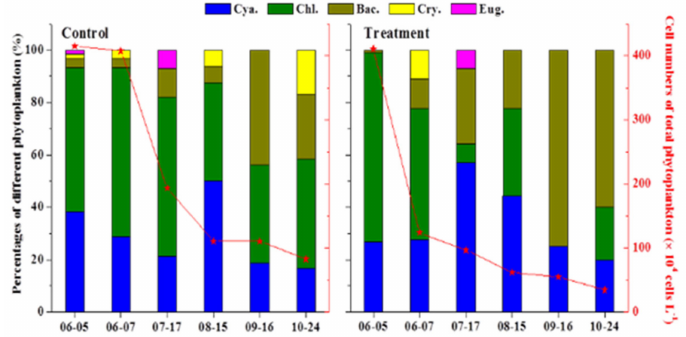
Figure 12. ( a ) The coverage and biomass of submerged vegetation in the control and treatment ponds after 4 months and ( b ) a 3-year monitoring result on submerged vegetation restoration in the treated pond.